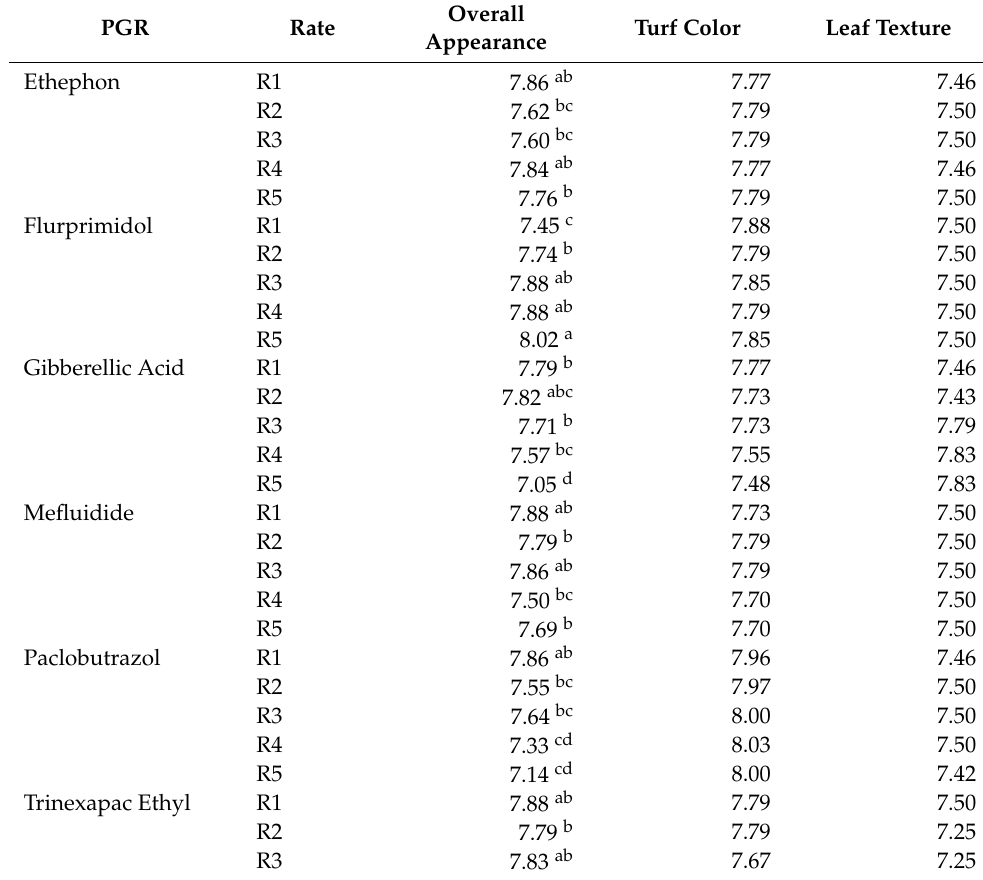
Table 5. Turfgrass quality score rating: overall appearance, turfgrass color, and leaf texture.